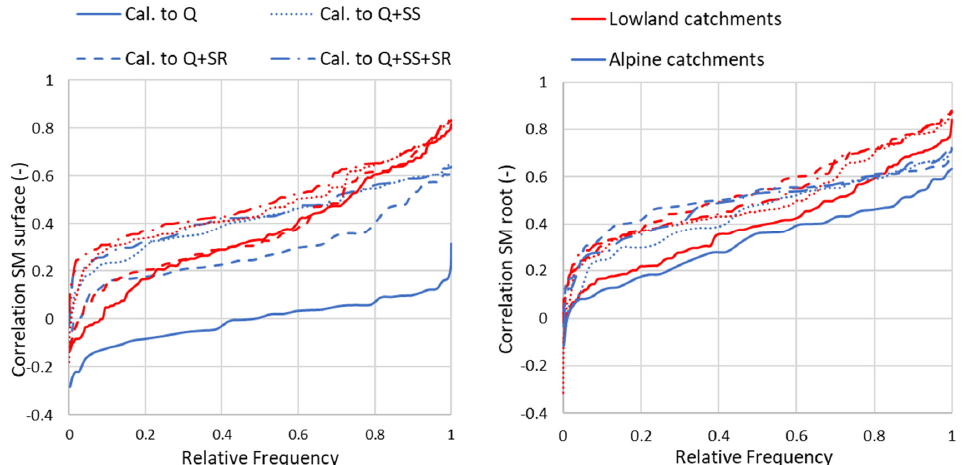
Figure 5. Cumulative distribution functions (CDFs) of the correlation coefficients of surface soil moisture (bottom left) and of the root zone soil moisture (bottom right) in the validation period 2015–2018. The CDFs are plotted for the four calibration variants. The red and blue lines show the calibration variants for the group of 124 Lowland (red) and 65 Alpine catchments (blue), respectively. When comparing the correlation coefficients between the simulated and measured soil moisture, we again detected better results in the Lowland than in the Alpine catchments and an improvement using the model parameters from a multi-objective calibration. In the surface soil layer, the median of the correlation coefficients increased from 0.01 (calibration only for the runoff) to 0.43 (the calibration to runoff, surface and root soil moisture) in the Alpine catchment and from 0.33 (calibration only for the runoff) to 0.48 (the calibration for the runoff, surface and root soil moisture) in the Lowland catchments. In the root soil layer, the median of the correlation coefficients increased from 0.36 (calibration only for the runoff) to 0.53 (the calibration for the runoff, surface and root soil moisture) in the Alpine catchments and from 0.40 (calibration only for the runoff) to 0.49 (the calibration for the runoff, surface, and root soil moisture) in the Lowland catchments, see Table 5. Table 5. Medians of the correlation coefficients of the surface and root soil moisture for the two groups of catchments (65 Alpine and 124 Lowland catchments) in the validation period 2015–2018. Calibration